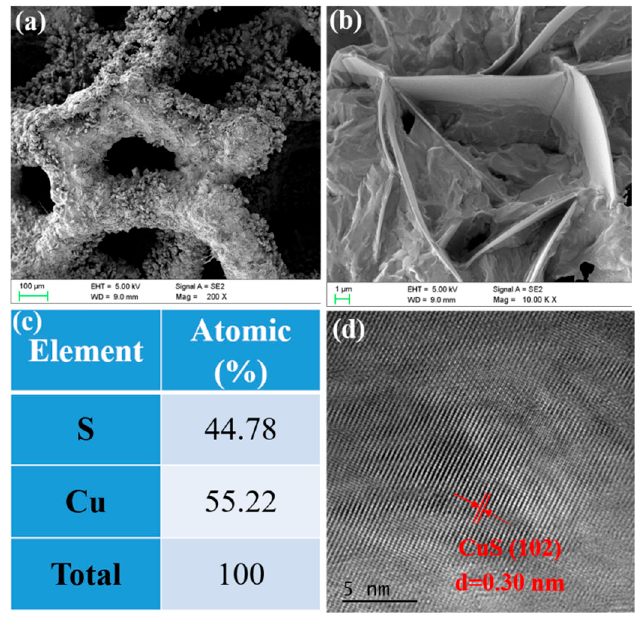
Figure 2. Characterization of CuS morphology: ( a , b ) SEM images in low and high magnification, ( c ) EDS results, ( d ) HRTEM image.